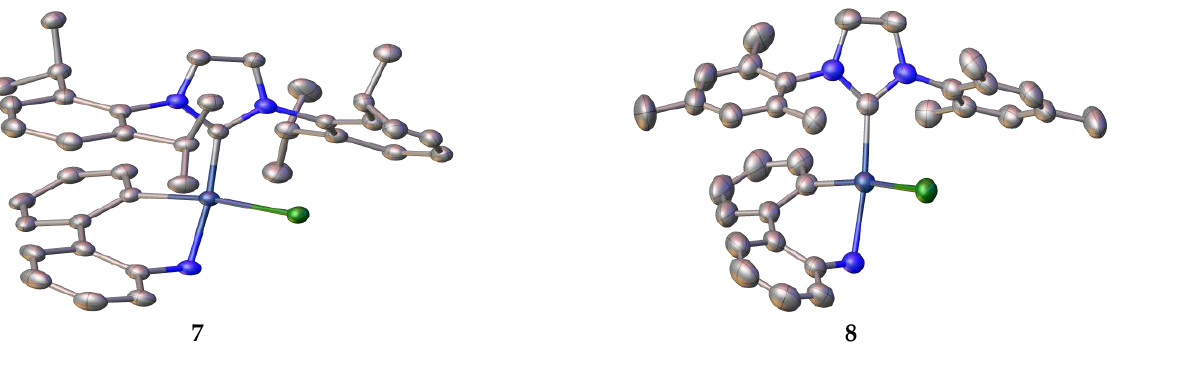
Figure 4. ( Left ) X-ray structure of palladacycle 7 ; selected bond distances (Å) and angles (deg): Pd1-Cl5 2.4146(9), Pd1-N3 2.095(3), Pd1-C1 1.996(3), Pd1 C67 2.004(4), CCDC 2241786; ( Right ) X-ray structure of palladacycle 8 ; selected bond distances (Å) and angles (deg): Pd1-Cl1 2.4331 (8), Pd1-C1 2.001 (3), Pd1-N3 2.109 (2), Pd1-C22 1.996 (3), C1-Pd1-N3 173.63 (12), CCDC 2225057. Ellipsoids are drawn at the 30% probability level, and hydrogen atoms have been omitted for clarity.